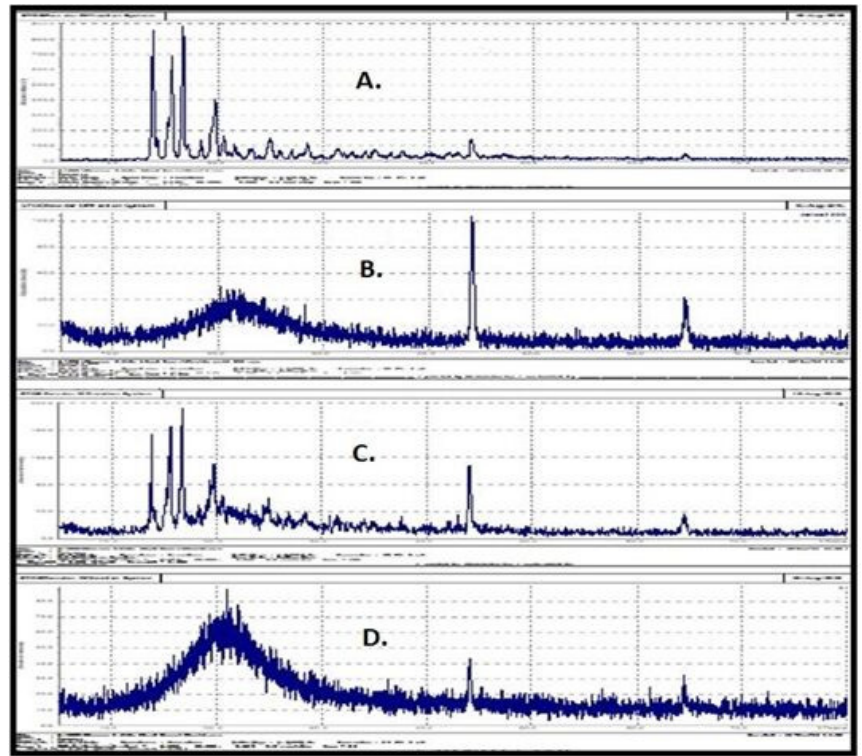
Figure 9. PXRD spectra of ( A ) Pure finasteride, ( B ) Aerosil 200 (blank carrier) ( C ) Physical mixture of finasteride and aerosil 200 and ( D ) Finasteride loaded S-SNEDDS powder.